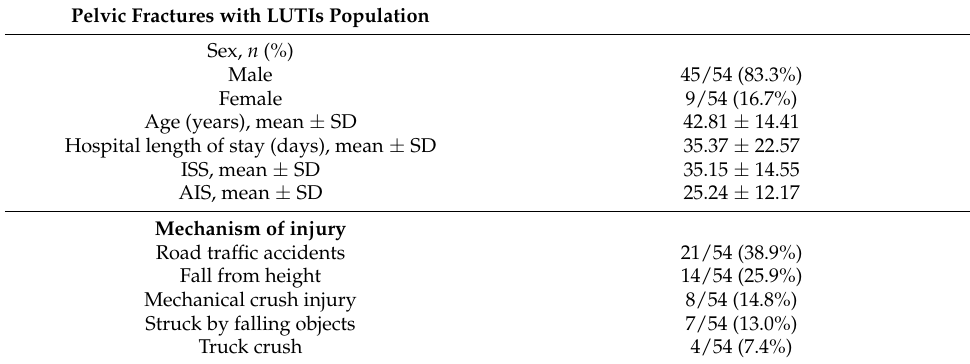
Table 1. Demographics of the study